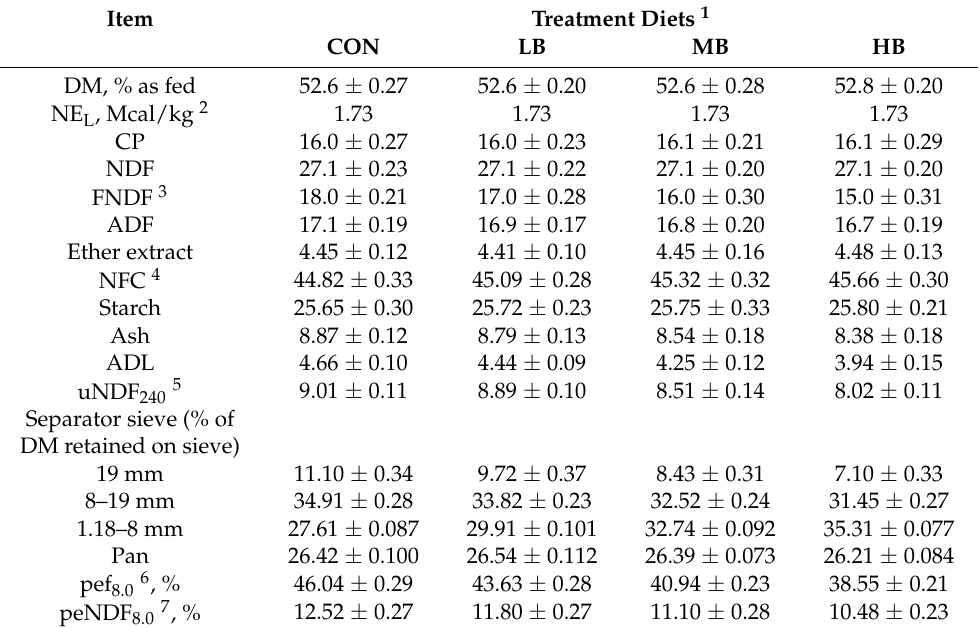
Table 1. Chemical composition of treatment diets fed to lactating cows (% of DM, unless otherwise